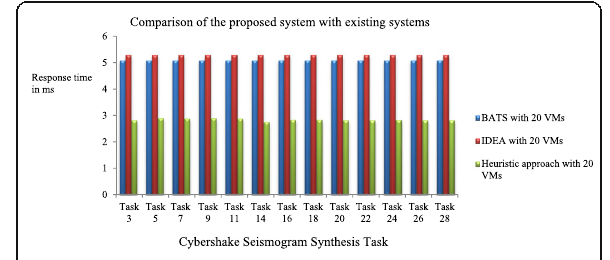
Fig. 8 Response time for cybershake tasks